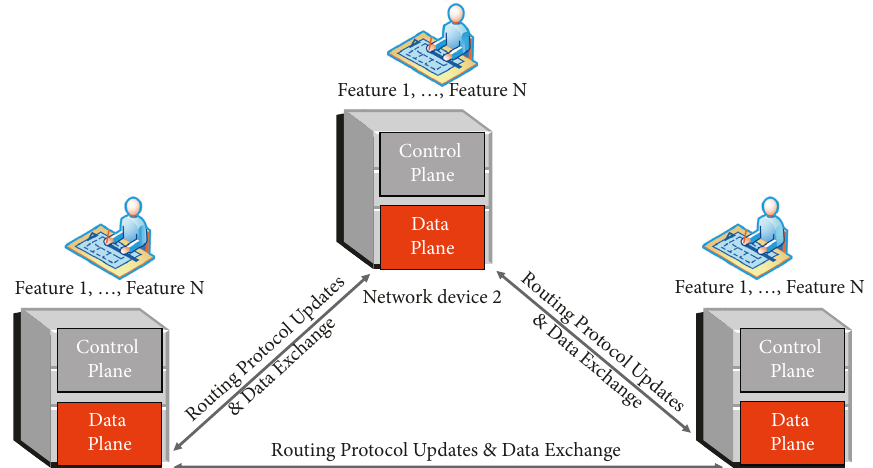
Figure 3: Traditional network